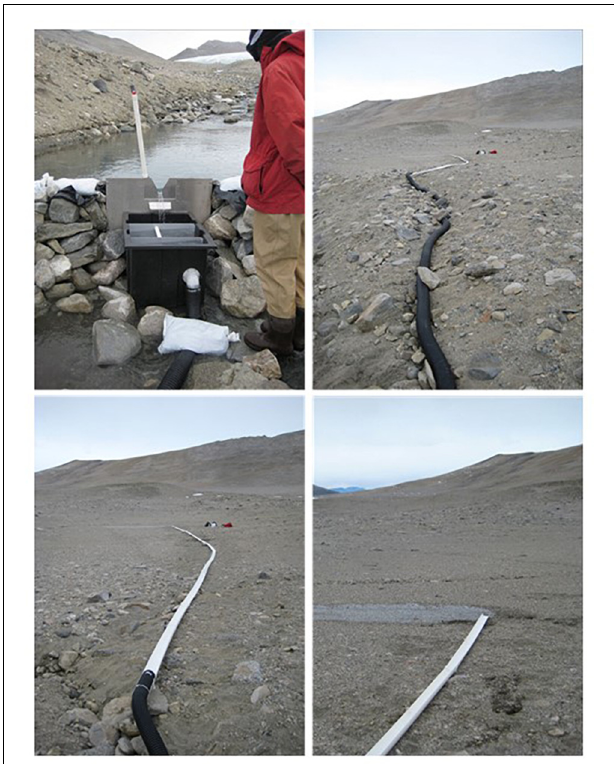
FIGURE 1 | Images of the dam, weir, and